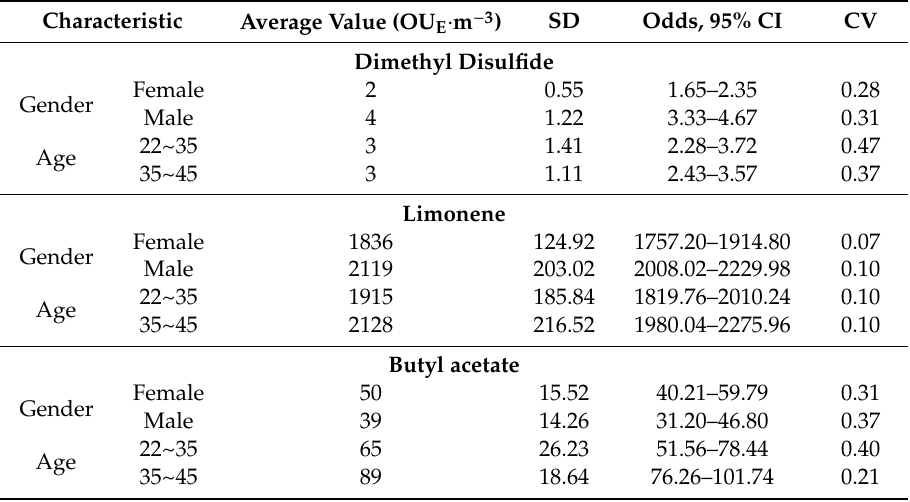
Table 5. The unpleasant critical points of di ff erent genders and